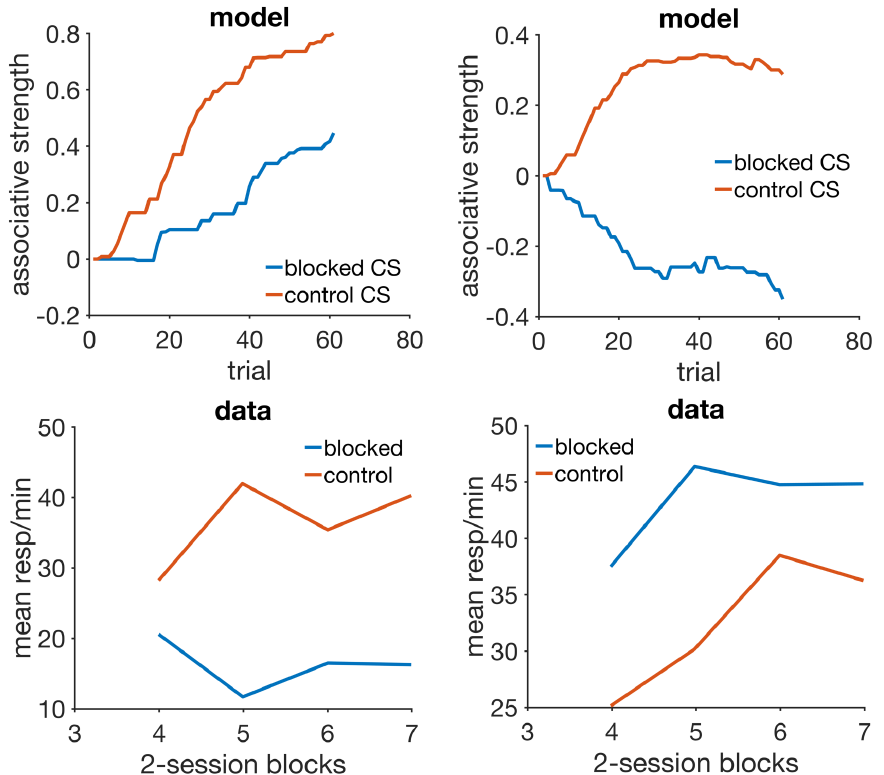
Fig 8. Blocking with different durations. Left column: simulation(top) with a 15 sec blockingCS and 10 sec blockedCS, and animal data (bottom) from an experiment with the same design.Right column:simulation (top) with a 10 sec blockingCS and 15 sec blocked CS, and animaldata (bottom) from an experiment with the same design.Data panels redrawn from the top right panel in Figure 5 in [86]. Model parameters: α t = 0.2, α V = 0.1, μ = 1, σ = 0.35, m = 0.2, H =